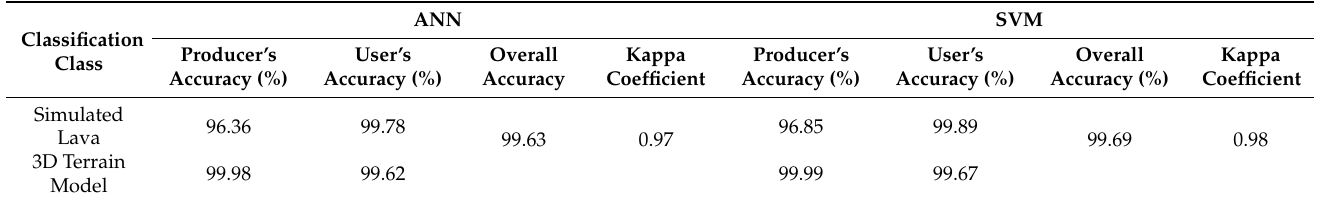
Table 3. Accuracies of the simulated lava classification based on the ANN and SVM